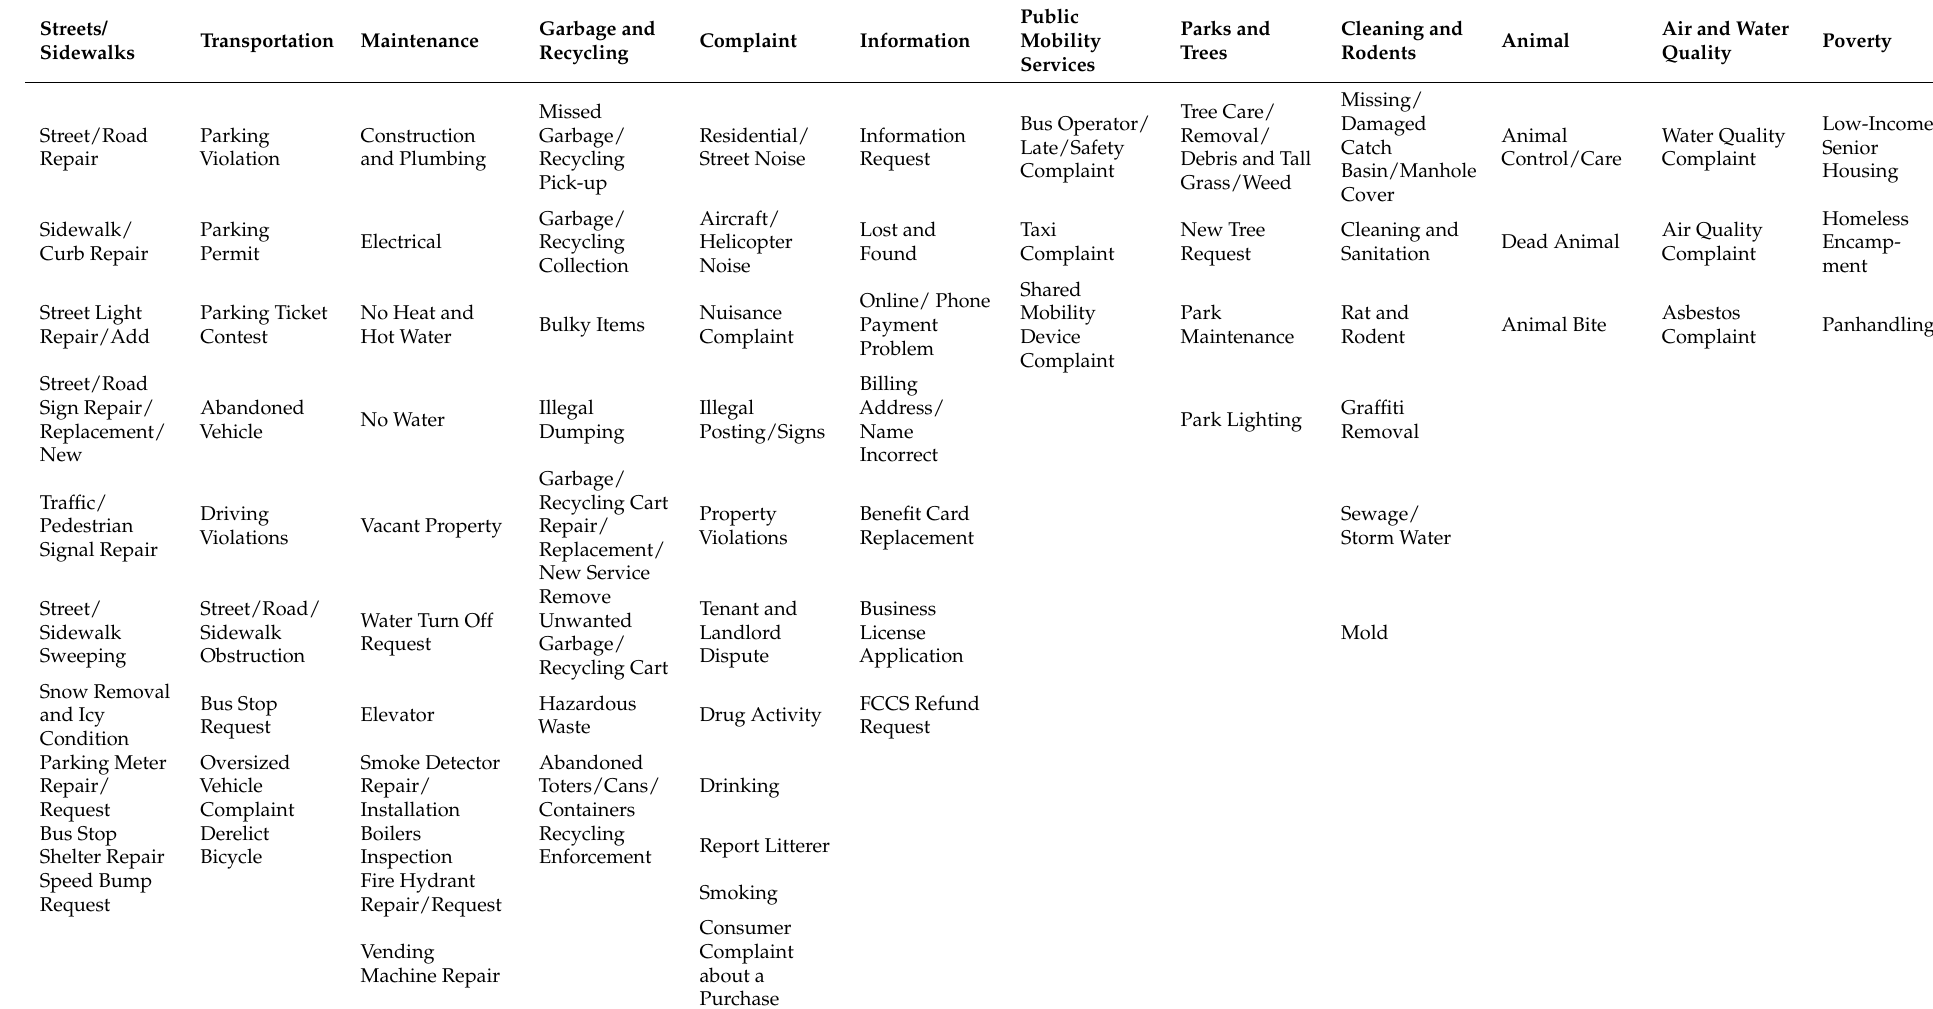
Table 2. Standardized SR types under twelve general